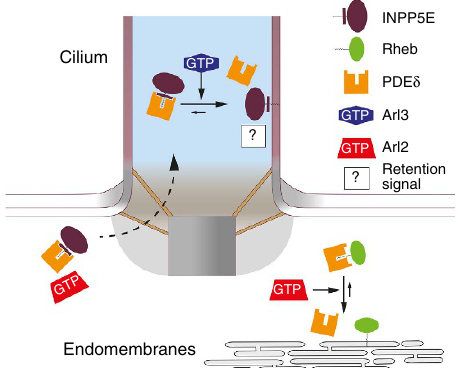
Figure 8 | Model of PDE6 d -mediated sorting of farnesylated cargo. High- affinity cargo such as INPP5E can be specifically released from PDE6 d by Arl3 (cid:3) GTP in the cilium, but not by Arl2 (cid:3) GTP in the cytosol. In contrast, low- affinity cargo such as Rheb can be released by Arl2 (cid:3) GTP. As a consequence, PDE6 d -free INPP5E can be specifically retained and thus be enriched in the ciliary compartment while PDE6 d -free Rheb is retained at endomembranes and stays outside the